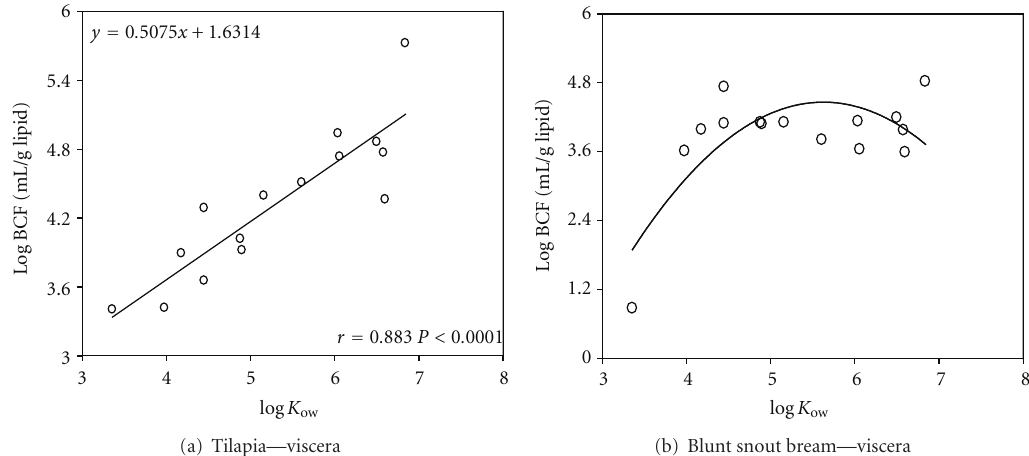
Figure 11: Correlations of log K ow with logBCF of viscera in tilapia (a) and blunt snout bream